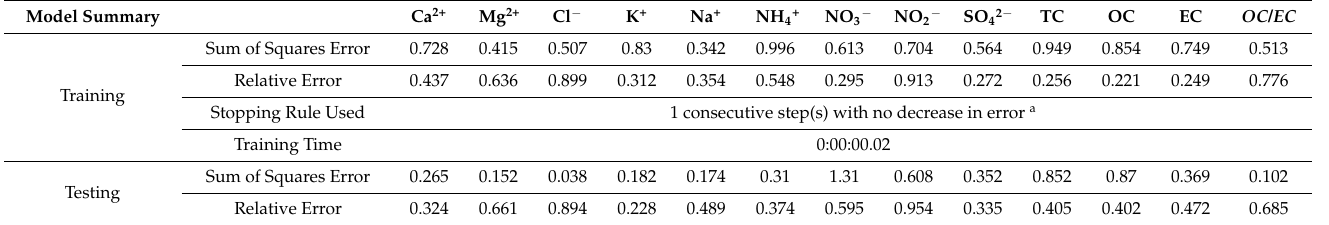
Table A3. Model summary of the